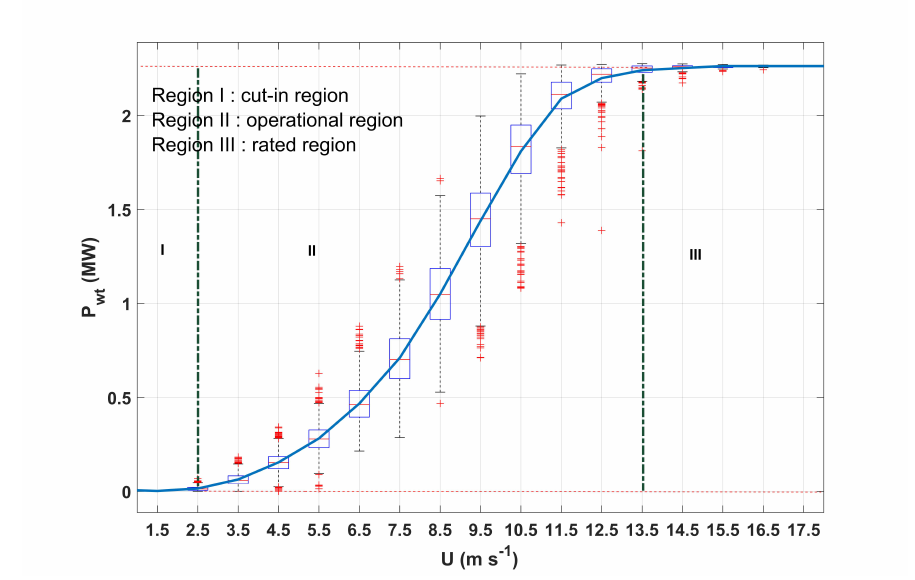
Figure 1. A power curve derived for the 2.5 MW study turbine, using ten-minute data during the period of study, spanning from 20 February to 18 June 2018 and bins of 1 m s − 1 . Cut-in region (I), operational region (II) and rated region (III) are also